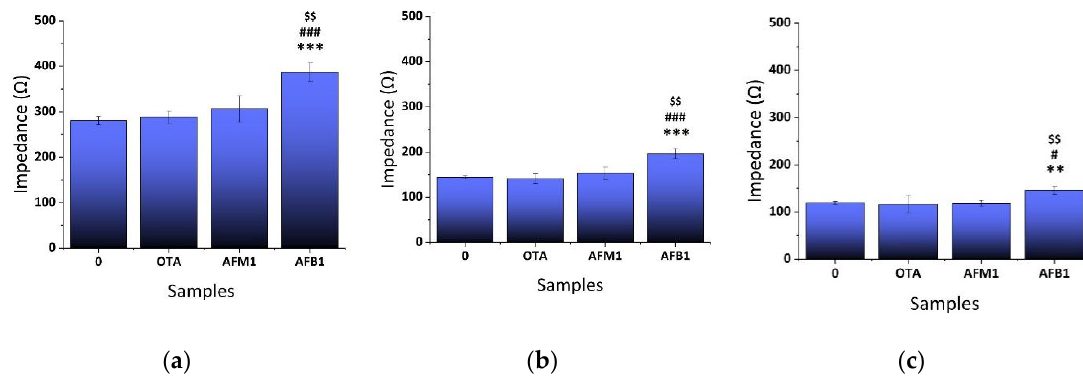
Figure 12. Extracted results from the mean impedance magnitude values for 0, and 10 ng/mL of Ochratoxin A (OTA), Aflatoxin M 1 (AFM 1 ) and Aflatoxin B 1 (AFB 1 ) standard solutions tested at ( a ) 1 KHz, ( b ) 10 KHz, and (c): 100 KHz. Two-tailed t-test, p ** < 0.01; p *** < 0.001 significantly di ff erent from the control, p # < 0.05; p ### < 0.001 significantly di ff erent from OTA, p $$ < 0.01 significantly di ff erent from AFM 1 .